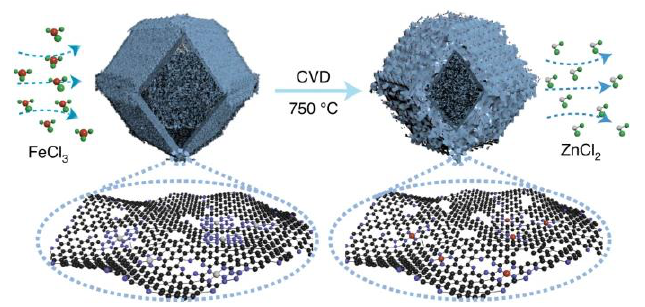
Figure 4. Preparation of FeNC-CVD-750 via CVD strategy. Reprinted with permission from Ref. [56]. Copyright 2021, Springer Nature.